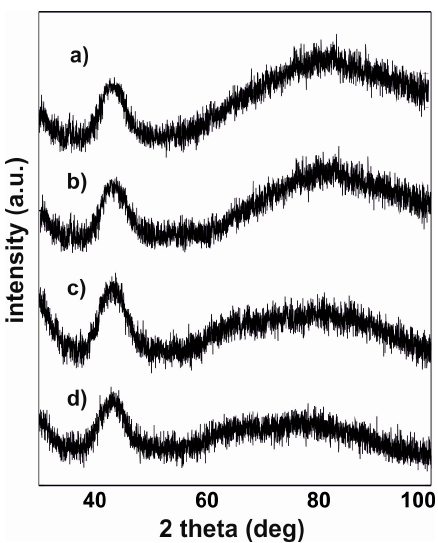
Figure 3. X-ray di ff raction images for the alloys: ( a ) Fe 36 Co 36 Y 8 B 20 , ( b ) Fe 39 Co 33 Y 8 B 20 , ( c ) Fe 43 Co 29 Y 8 B 20 , ( d ) Fe 48 Co 24 Y 8 B 20 .